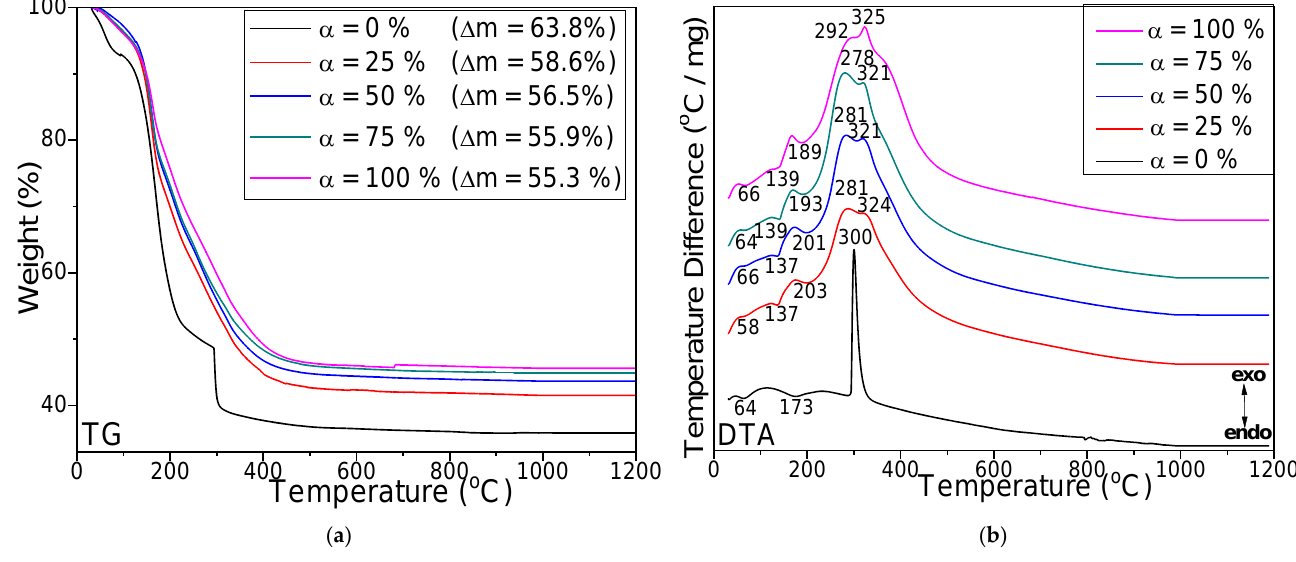
Figure 1. TG ( a ) and DTA ( b ) curves of (Co 0.4 Zn 0.4 Ni 0.2 Fe 2 O 4 ) α (SiO 2 ) 100 − α samples dried at 40 ◦